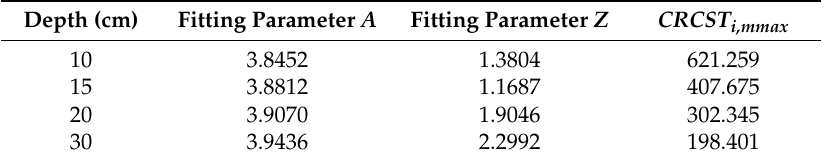
Table 3. Values of the fitting parameters A and Z and CRCST i,mmax for the site C.